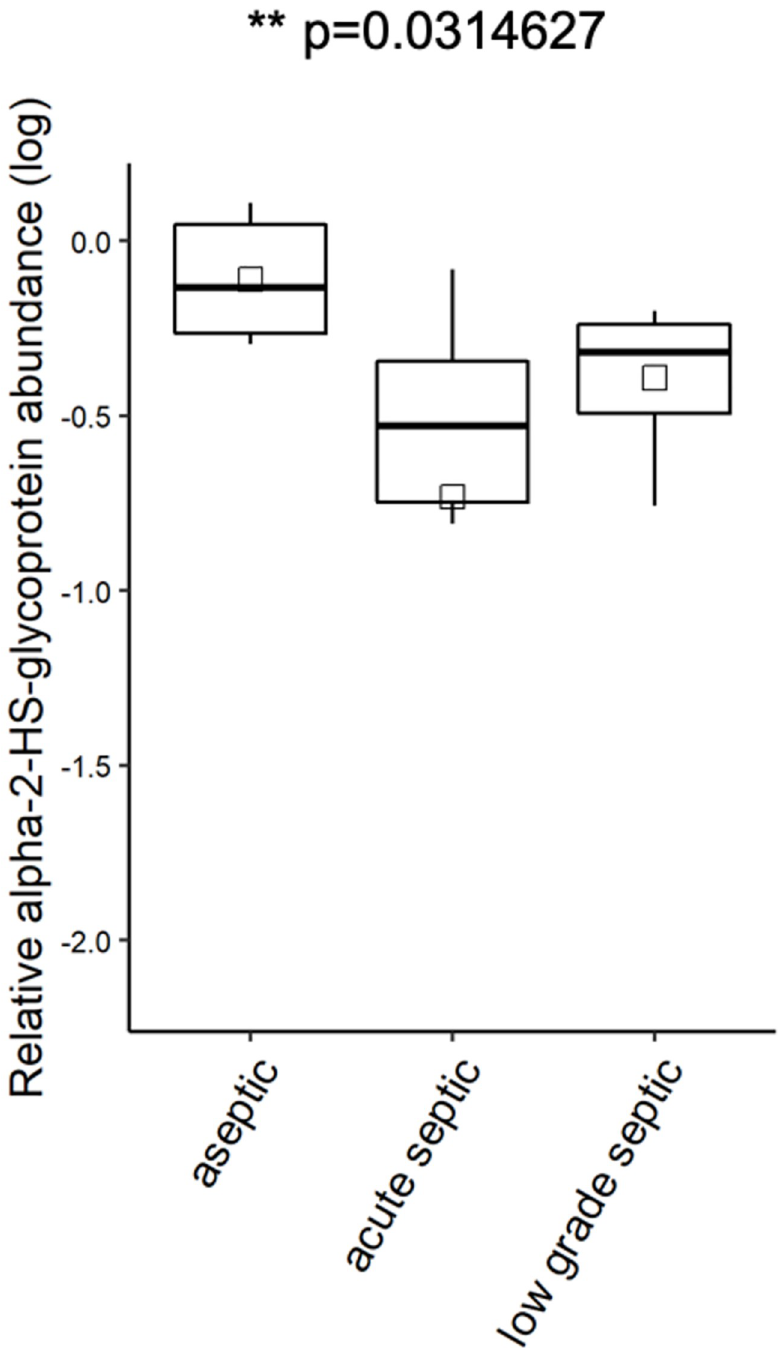
Fig 8. The relative alpha-2-HS-glycoprotein abundance (log). AHSG was presented in a significantly higher concentration in the sterile group, than in the acute septic or low-grade septic group. (p = 0.0314627, ANOVA